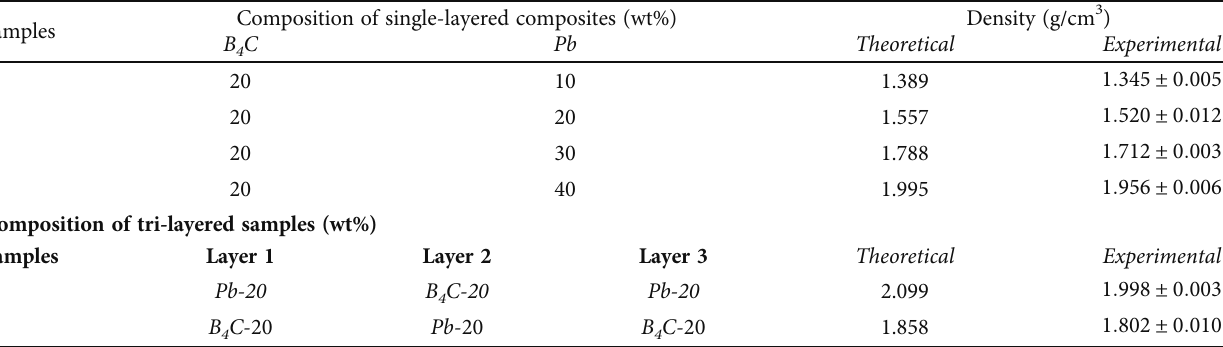
Figure 1: (a) SEM-EDS con fi rmation of B4C particles; (b) SEM-EDS con fi rmation of Pb particles; (c) manufacturing route-layered molding and curing, and (d) as-prepared samples for mechanical and radiation shielding Table 1: Composition of the samples.